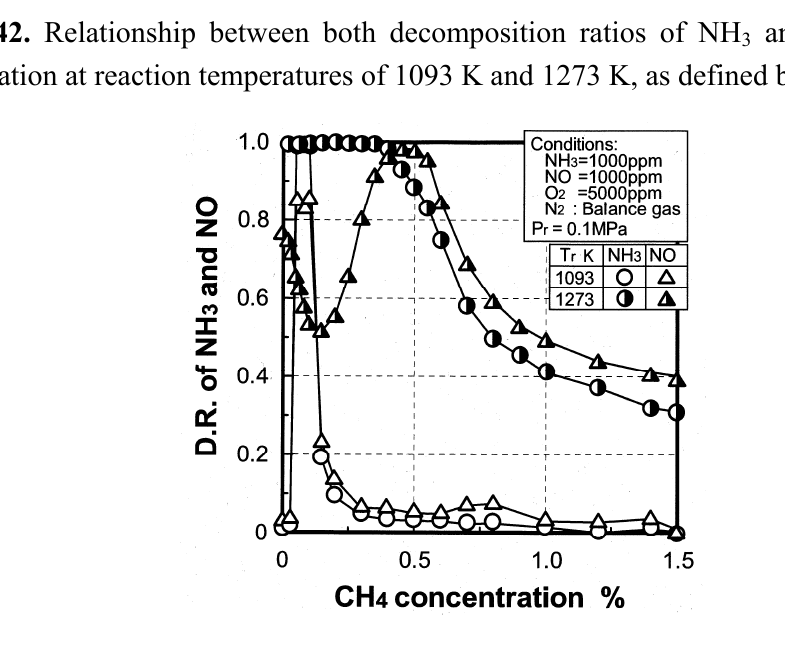
Figure 43. Effect of CH concentration on production of some species at reaction 4 temperatures of 1093 K and 1273 K, as defined by